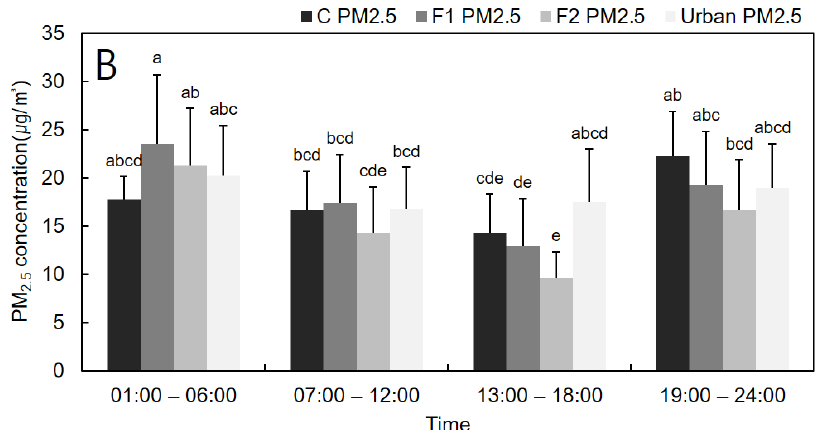
Figure 2. Diurnal changes in PM concentration ( µ g/m 3 ) in the Yeouido Saetgang Ecological Park. ( A ) Hourly PM 10 concentration at the measuring points. ( B ) Hourly PM 2.5 concentration at the measuring points. The same letter indicates no significant difference between measurements ( p < 0.05, one-way analysis, ANOVA, and then Tukey’s test for multiple comparisons). Values are shown as means ± standard deviation. C; control, F1 and F2; urban forest site 1 and 2, respectively, Urban; Urban area.